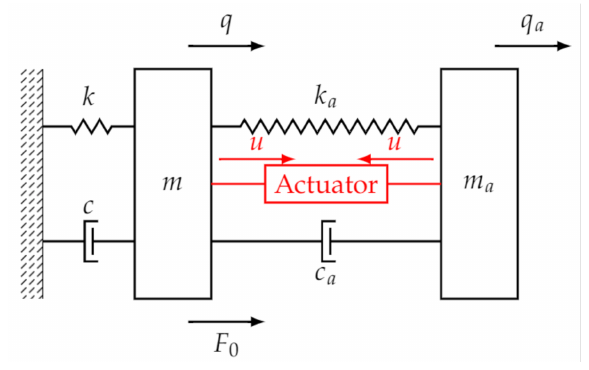
Figure 1. A sketch of an